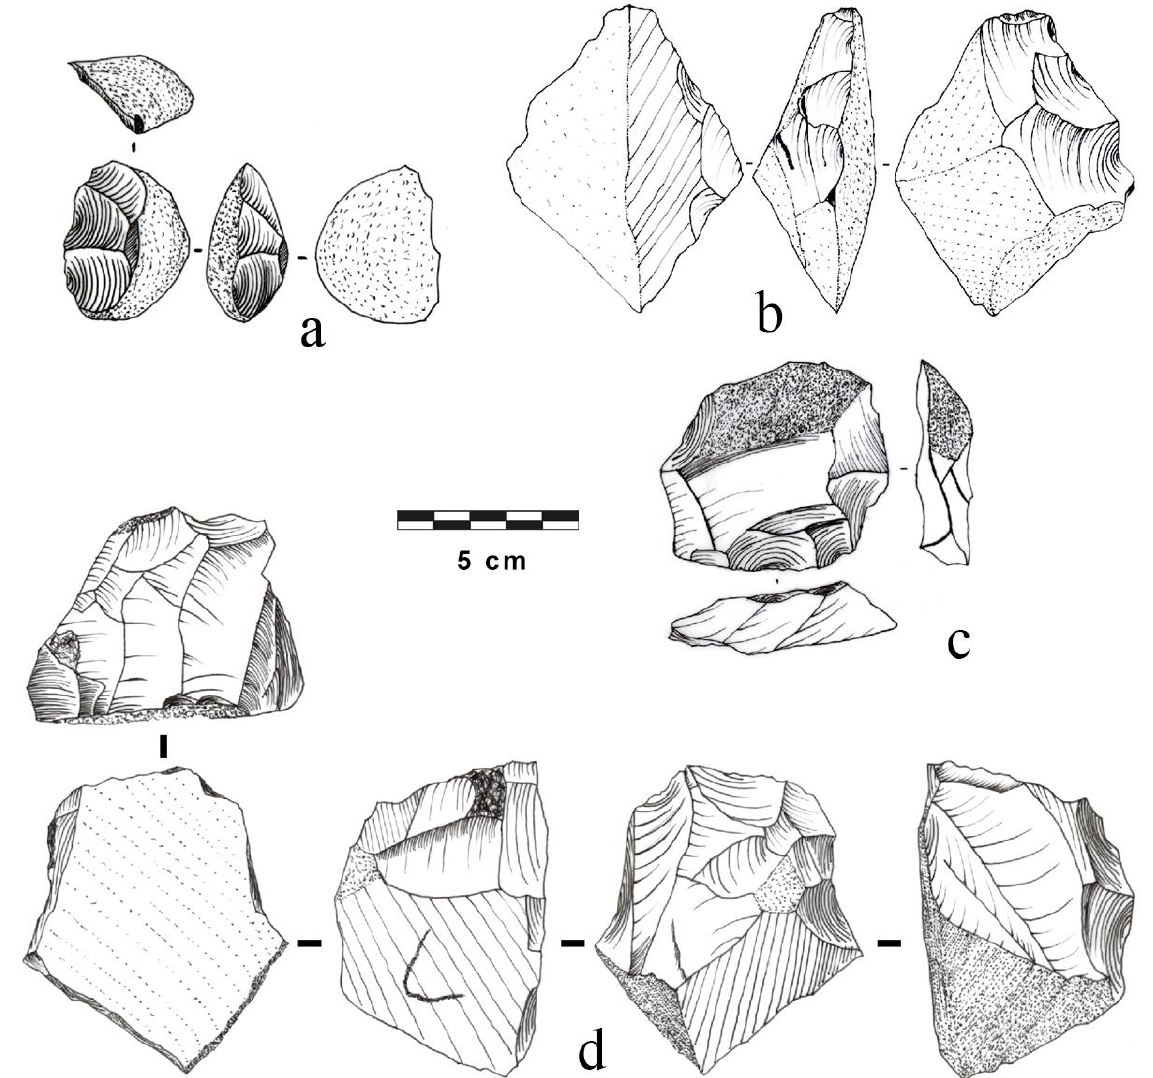
Figure 19. Other shaped tools. a. lateral edge modified pebbles; b. and c. thick retouched flakes; d. shaped